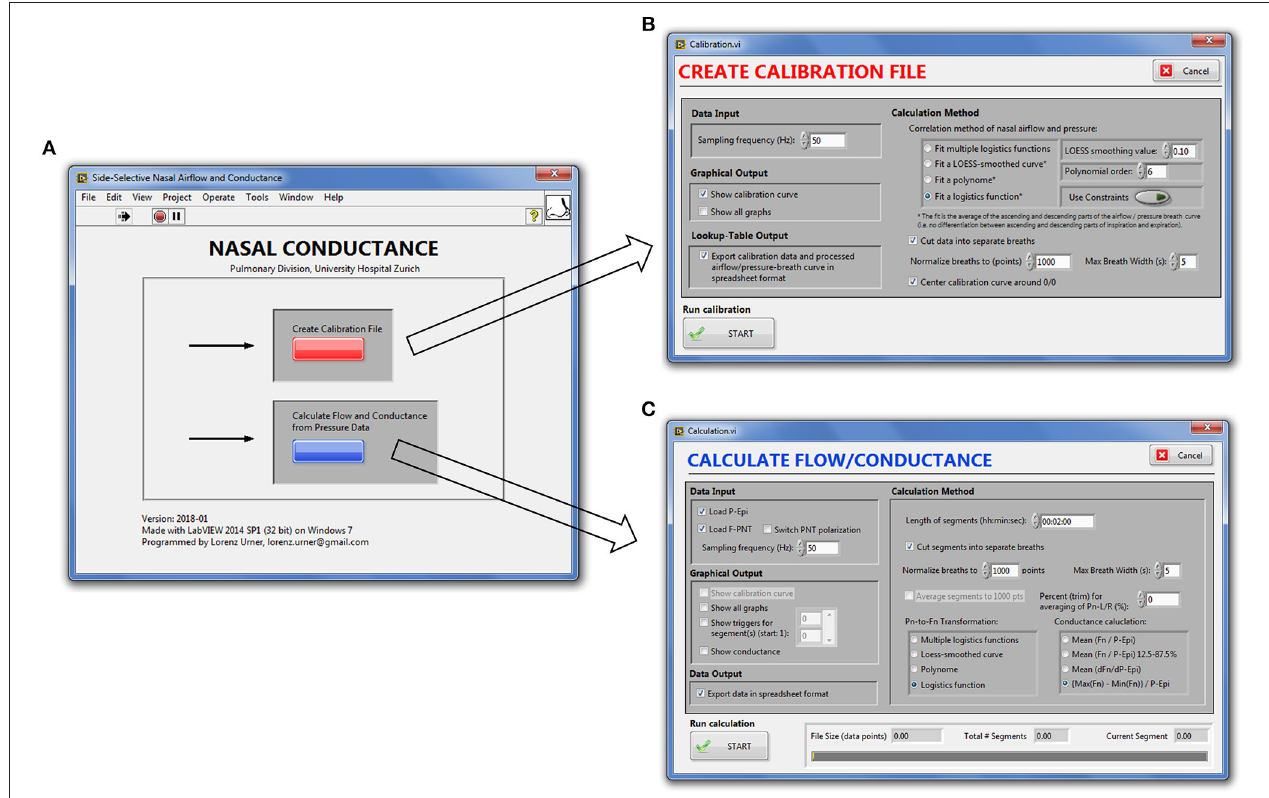
FIGURE 2 | Graphical user interface of the nasal pressure and airflow processing program. (A) , Main window. (B) , Calibration module. (C) , Module for derivation of bilateral airflow and conductance from nasal pressure recordings.